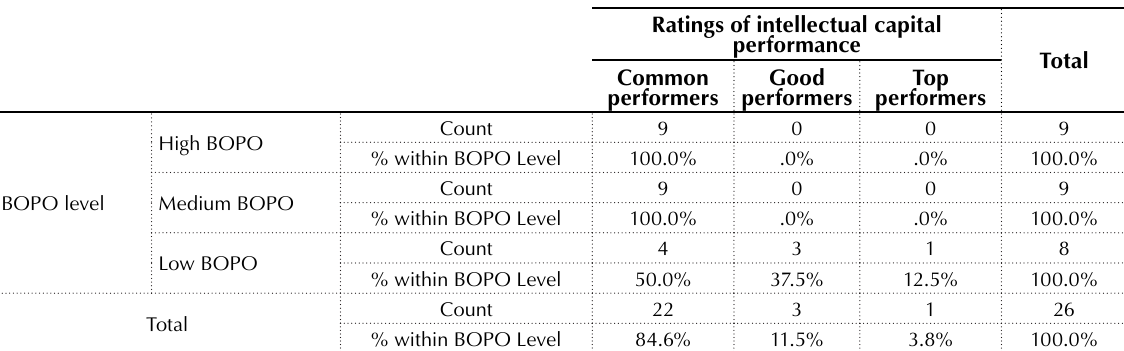
Table 5. Crosstab tabulation of ratio of operating expenses to operating income with ratings of intellectual capital performance